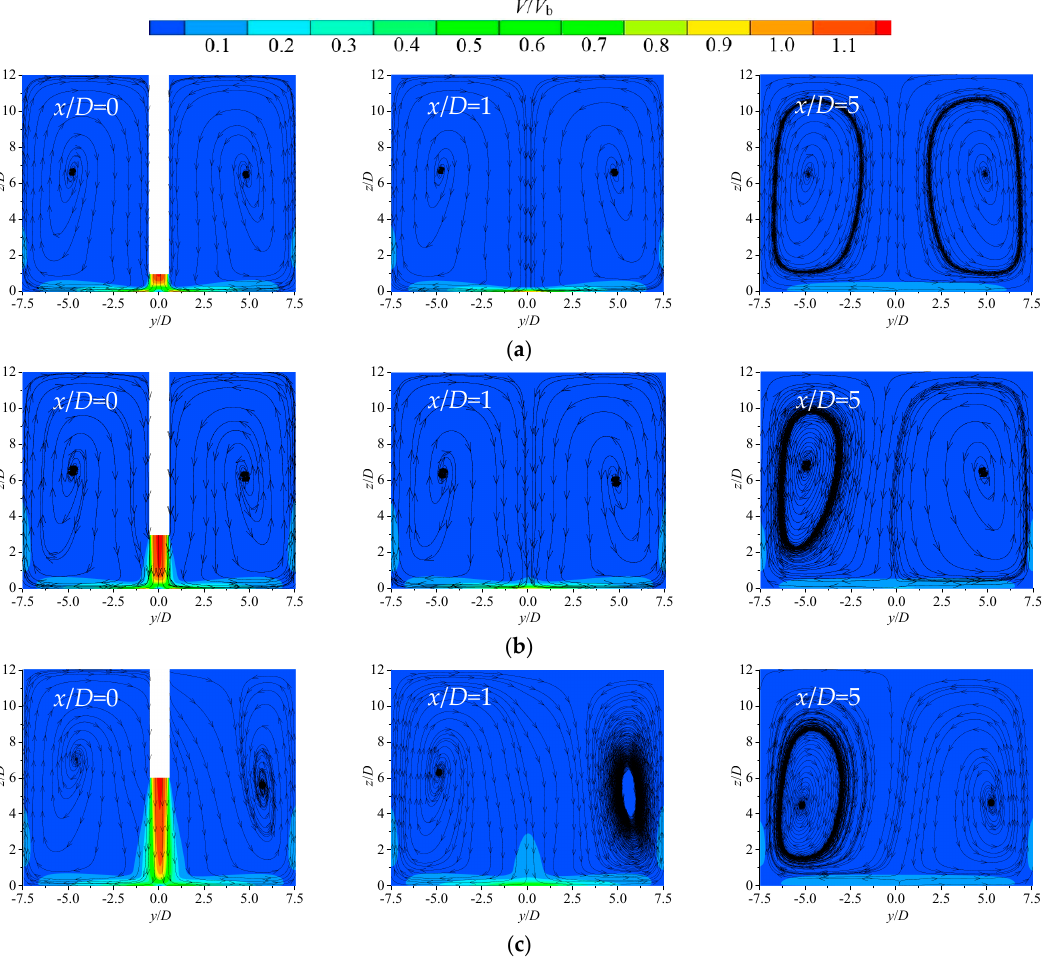
Figure 7. Normalized mean velocity V / V b contour and streamline of different vertical cross sections on submerged impinging jet at various impinging height ： ( a ) H / D = 1; ( b ) H / D = 3; ( c ) H / D = 6.